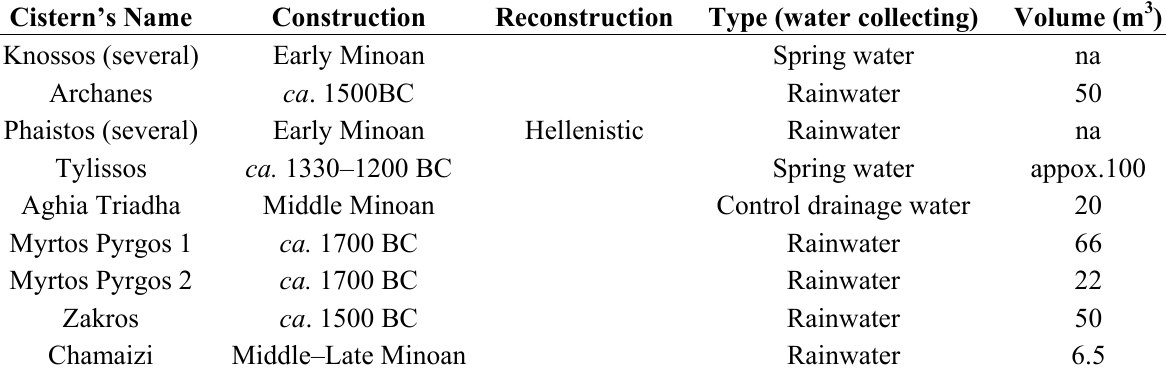
Table 1. Minoan Cisterns (adapted from